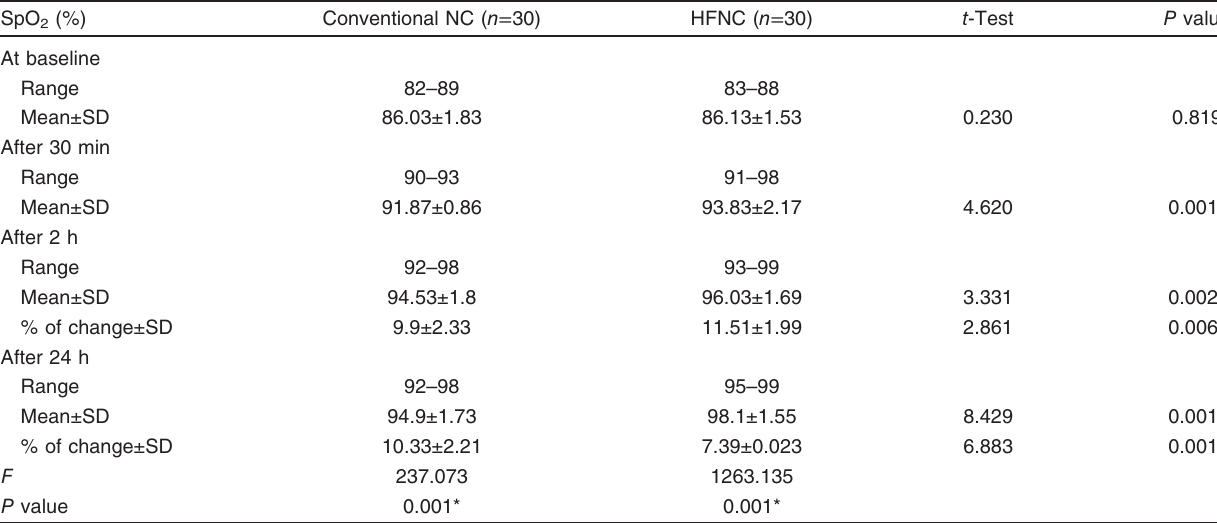
Table 6 Comparison of SpO 2 between the two studied groups